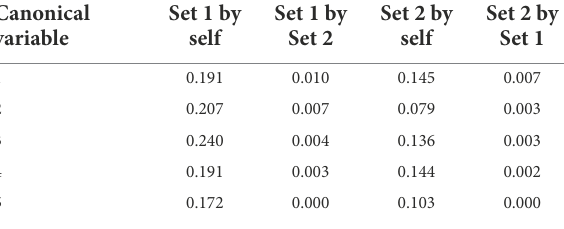
TABLE 5 Proportion of variance accounted for among set of personality dimensions and set of linguistic features. Canonical